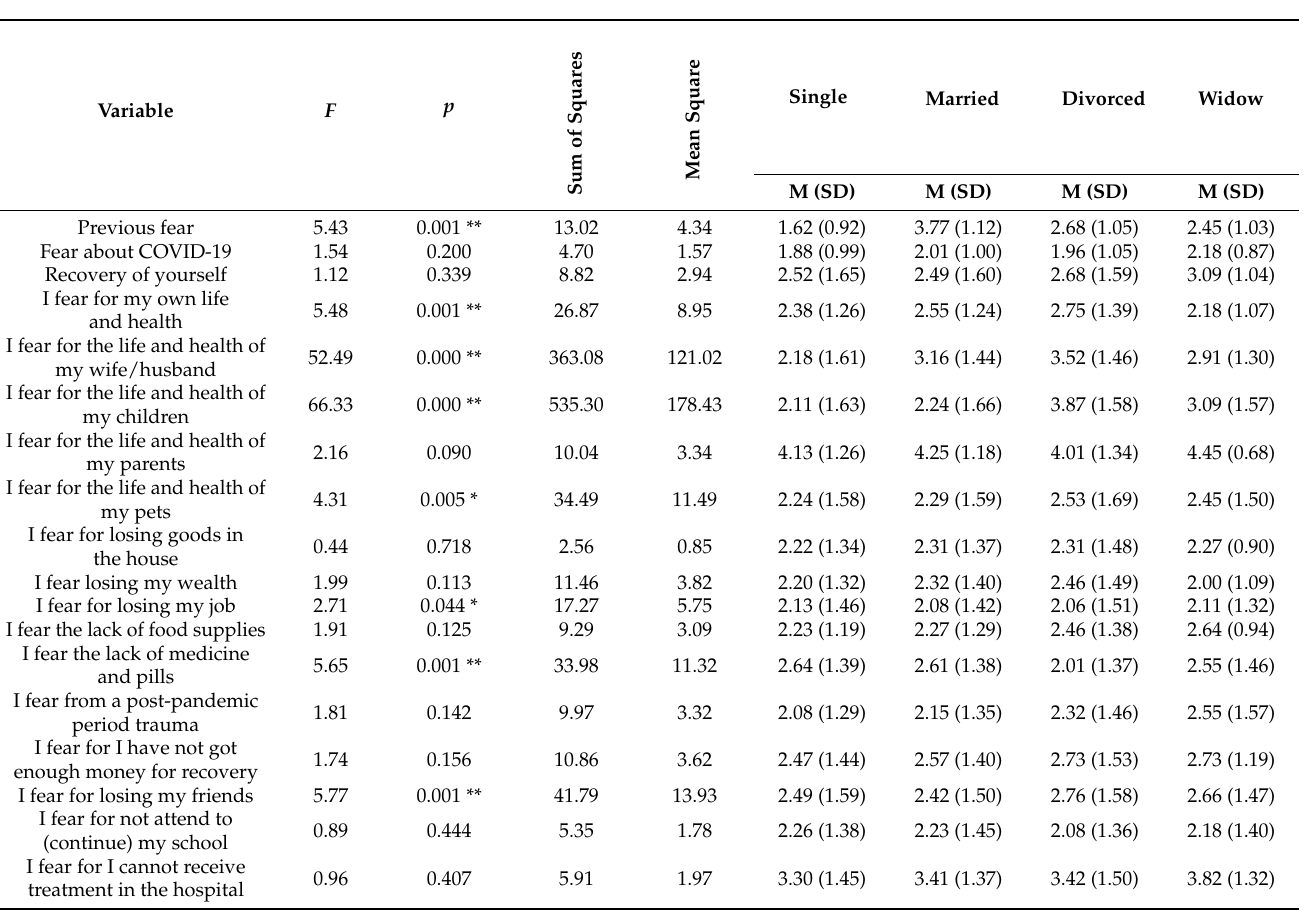
Table 3. One-way ANOVA results of the relations between the variables about fear caused by COVID-19 and marital